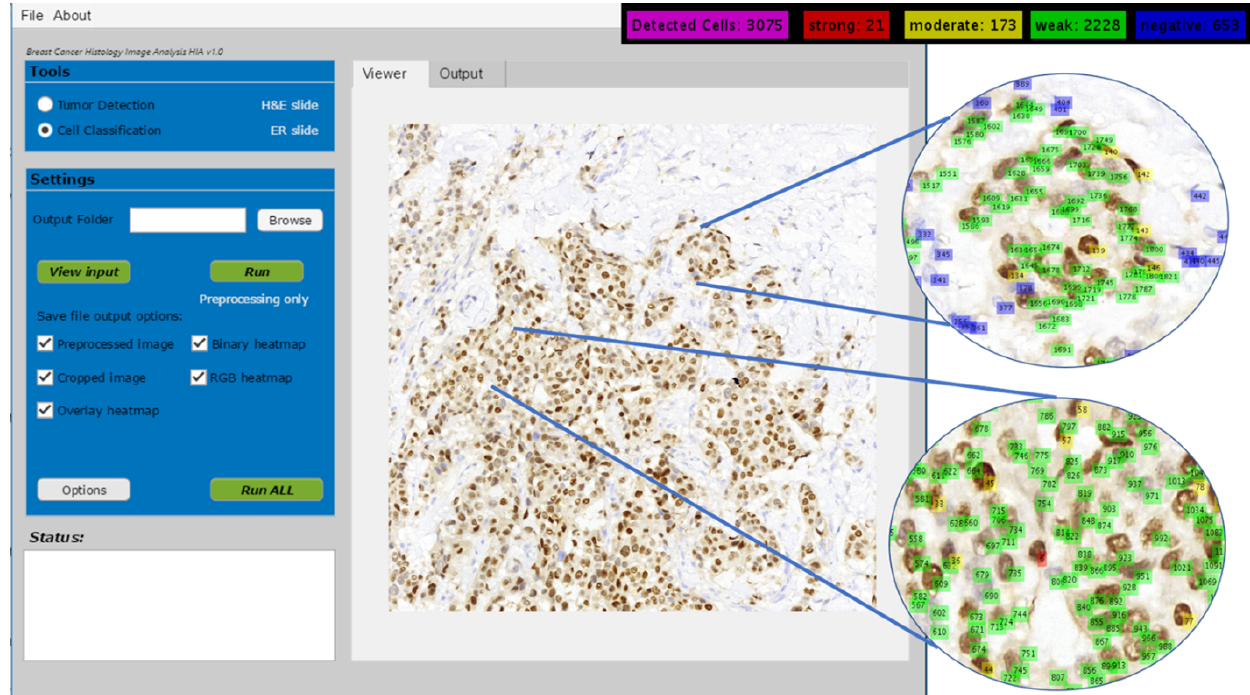
Figure 8. Examples of the classification results for 4 regions. Legends: blue (negative), green (weak), yellow (moderate), and red (strong).